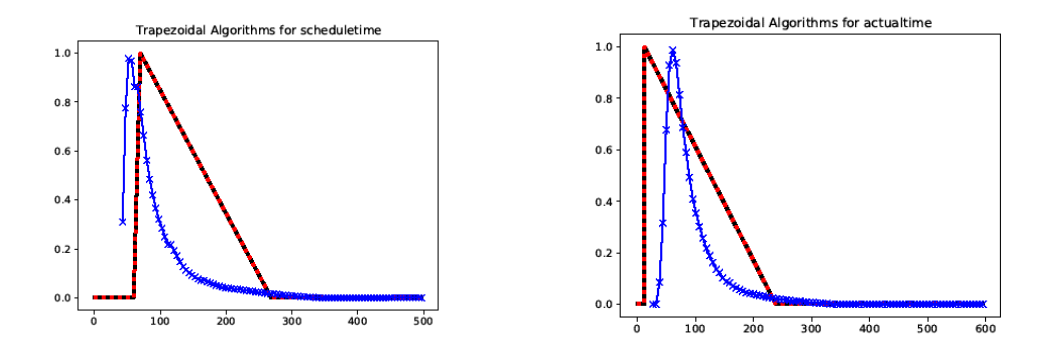
Fig. 6. Transformation result for real data (X-axis shows the duration in Min)